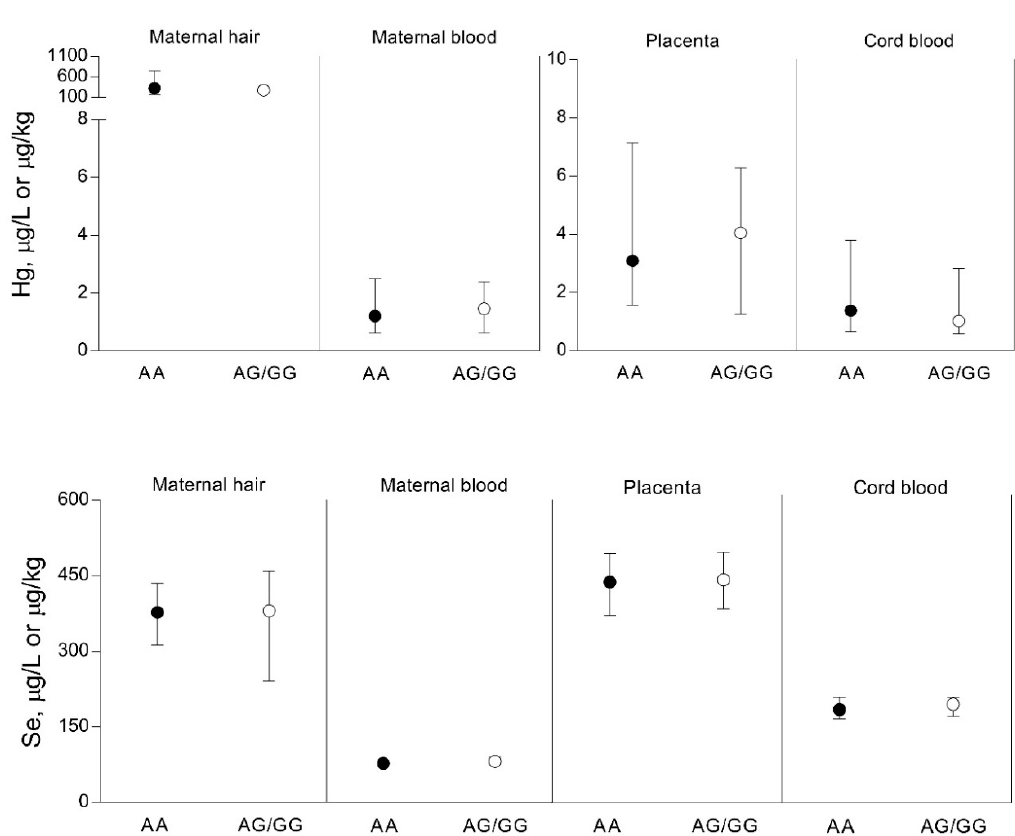
Figure 5. Concentrations of Hg and Se in maternal hair and blood, placenta, and umbilical cord blood in the study participants from Croatia ( n = 268) related to MT2A -5A / G polymorphism. Subgroups are denoted by the genotype: AA: wild-type ( n = 253); AG / GG: G allele carriers ( n = 15). Data are presented as the median and interquartile range (25%–75%).